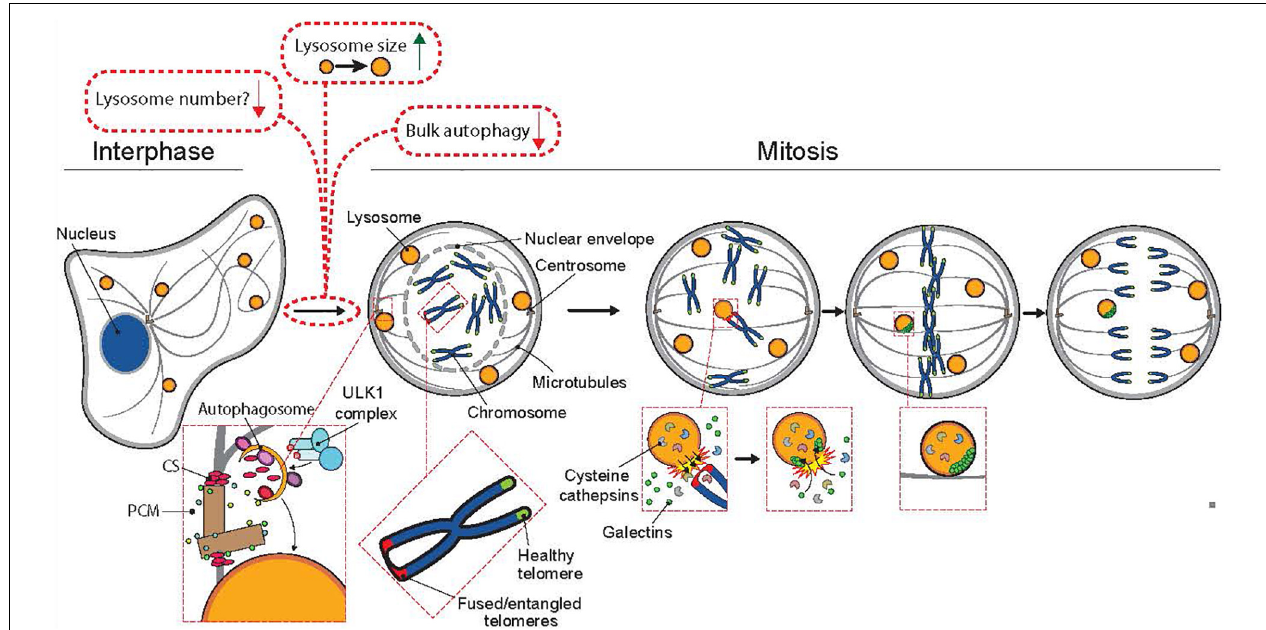
FIGURE 2 | The involvement of lysosomes and autophagy in mitosis. Mitotic cells have reduced autophagic activity and fewer but larger lysosomes than interphase cells. Upon entry to mitosis, bulk autophagy is shut down by CDK1 (see Figure 1 for additional information). In prophase, doryphagy, a type of selective autophagy targeting the centriolar satellites (CS), maintains centrosome integrity, which ensures the formation of a bibolar spindle. The breakdown of the nuclear envelope marks the onset of prometaphase, where the chromosomes can interact with the kinetochore-microtubules of the mitotic spindle. In prometaphase, a few lysosomes are recruited to the proximity of chromosomes with unresolved telomere fusions or entanglements, where their limiting membrane is transiently permeabilized resulting in the release of lysosomal cathepsins into the chromatin and entrance of galectins (marker proteins for lysosomal membrane permeabilization) into the lysosomes. Cathepsin B-mediated cleavage of histone H3 assists the segregation of the fused or entangled chromosomes in anaphase thereby preventing chromosome segregation errors, micronuclei formation and chromosomal